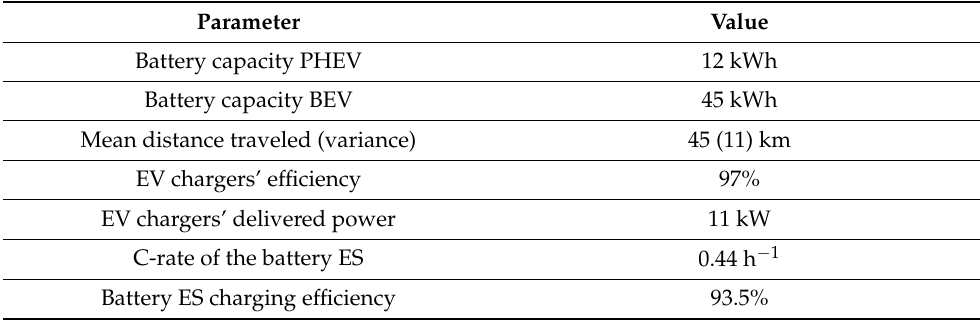
Table 1. Assumptions based on statistical data and